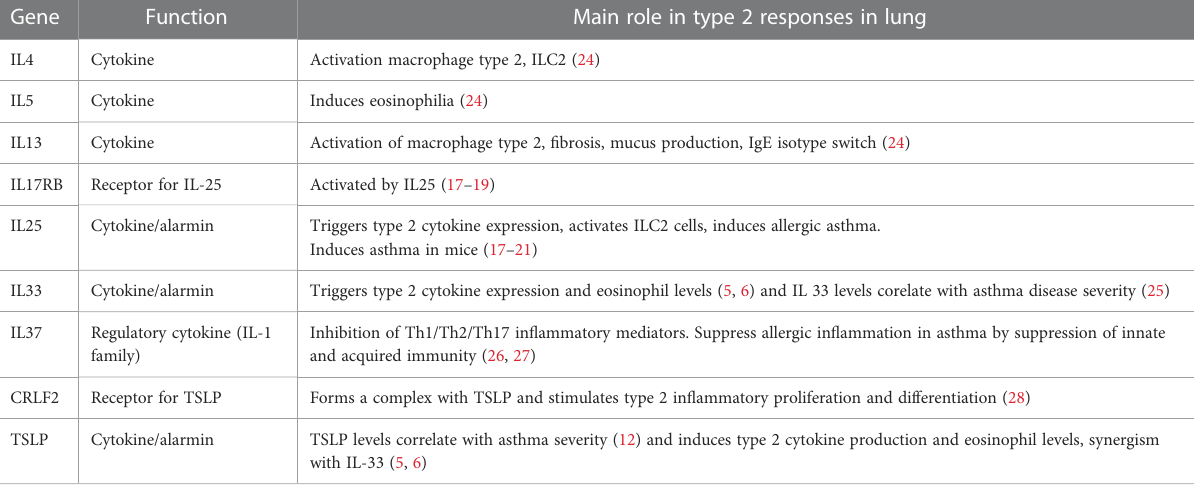
TABLE 1 Description of the selected candidate genes and their role in type 2